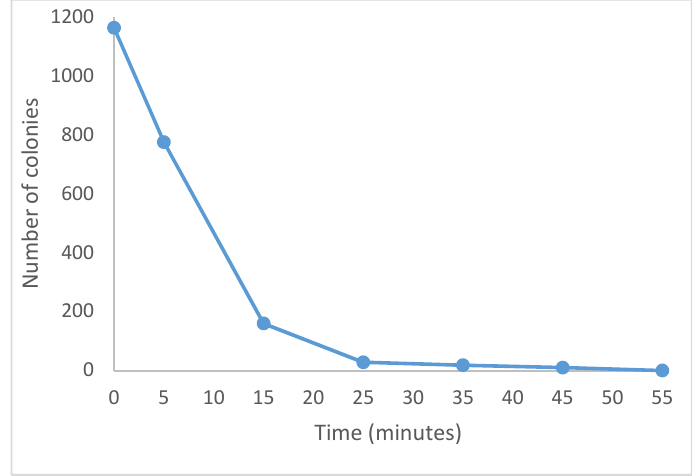
Figure 6. Biocomposite effect (5% Ag) on Escherichia coli colonies number at different times.